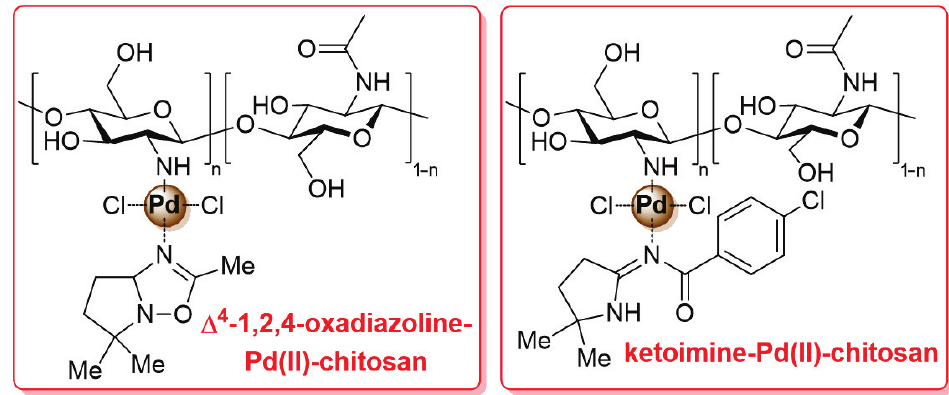
Figure 6. Chemical structure of Δ 4 -1,2,4-oxadiazoline-Pd(II)-chitosan and ketoimine-Pd(II)-chitosan catalysts, developed in 2011 by Pombeiro and co-workers [103].